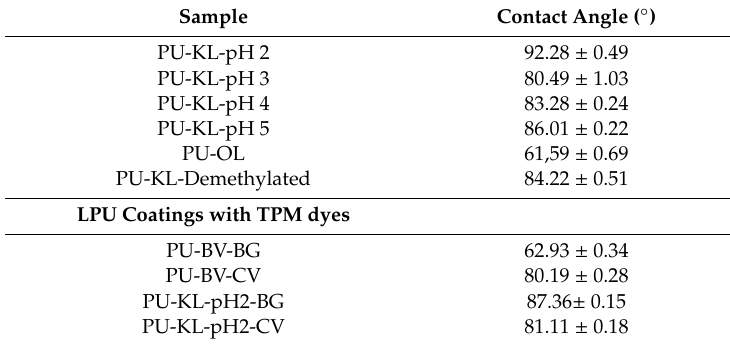
Table 7. Results of contact angle measurements of the di ff erent LPU. Abbreviations: polyurethane